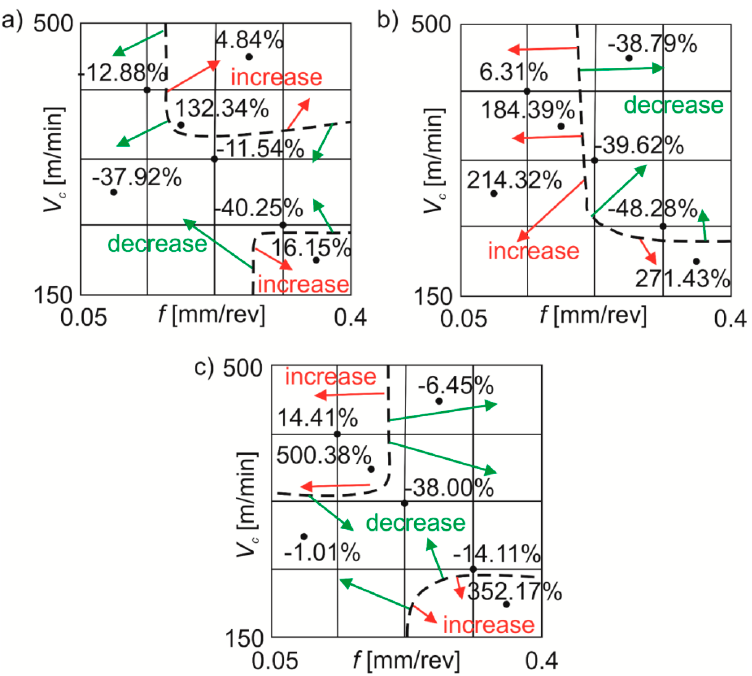
Figure 8. Average percentage changes in the Sz roughness parameter under: ( a ) wet turning; ( b ) MQL; ( c ) MQL+EP conditions in comparison with dry turning.